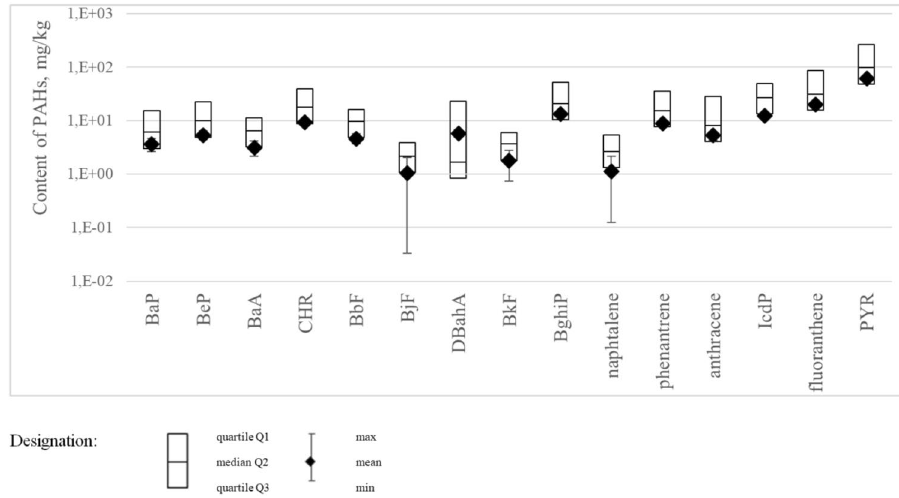
Figure 6. Statistical parameters for the results of tests for PAHs content in rubber granules.